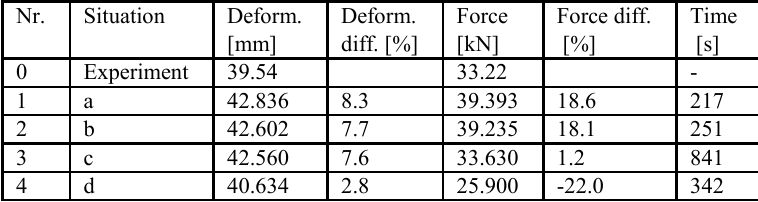
Table 5 – non uniform grid mesh